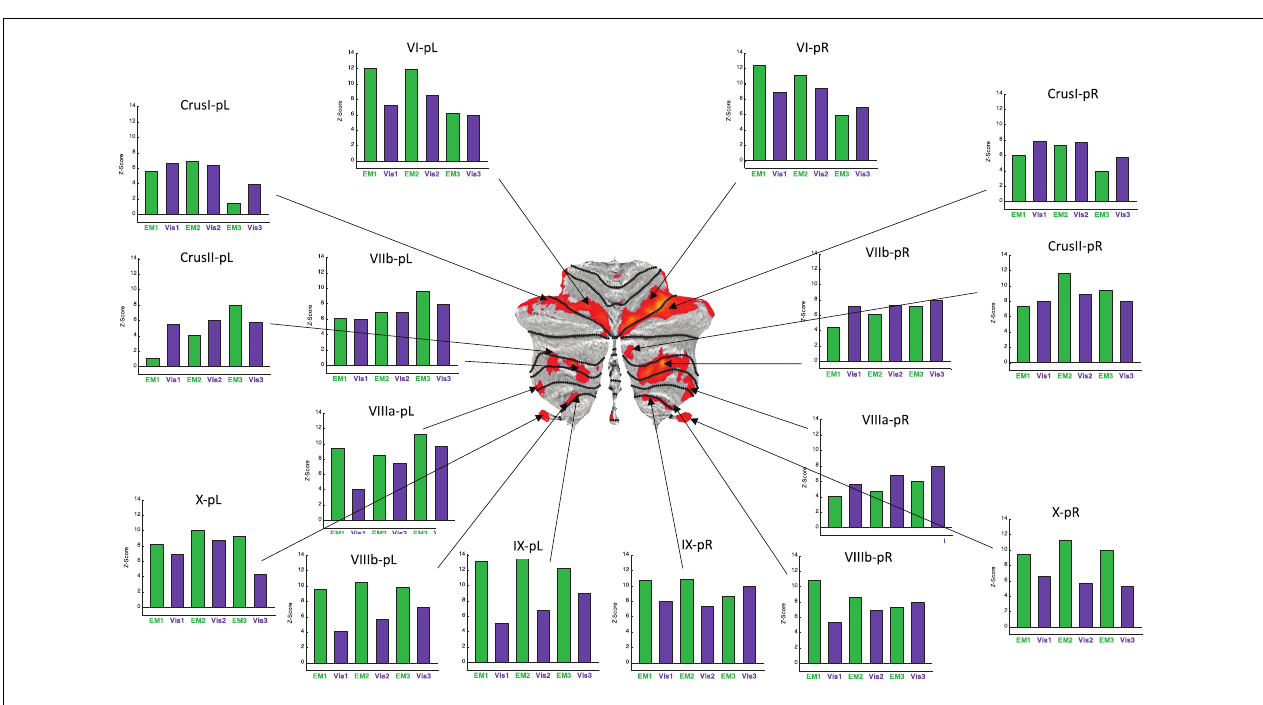
FIGURE 6 | Activation patterns for the positive cerebellar ROIs identified in the present protocol. Visualization ( Vis ) and Explore and Memorize ( EM ) task periods are coded by the green and purple bars, respectively. Note that the activation strengths in both tasks was generally similar for left and right hemisphere in the most rostral and caudal ROIs (in the flatmap framework). Note that the responses are plotted as z-scores. For this sample, z-scores of > 2.45 are significant at p < 0.05 (two-tailed) and z-scores > 5.95 are significant at p < 0.001 (two-tailed), etc. All specified ROIs reach the higher criterion for significance in at least one repeat in each of the